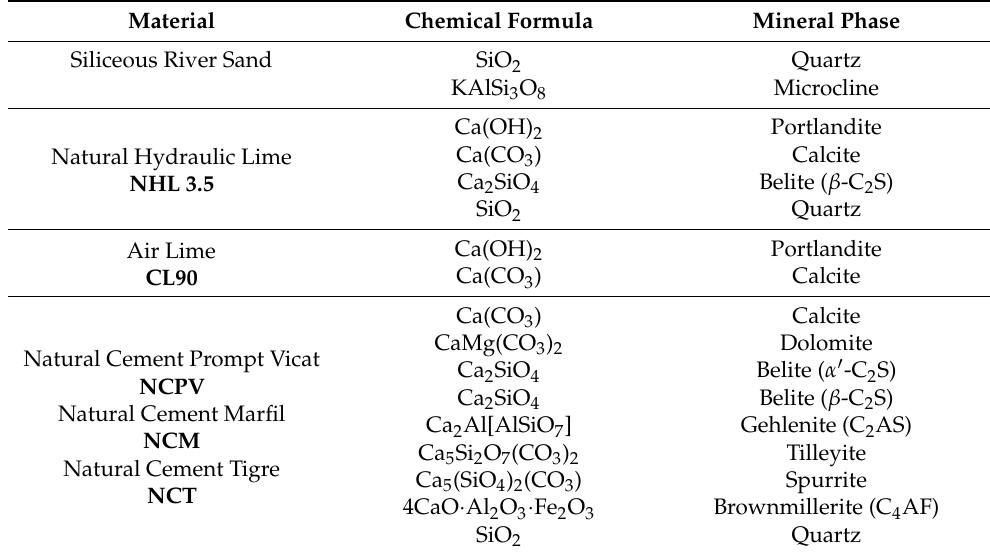
Table 4. Mineralogical composition of materials identified by XRD